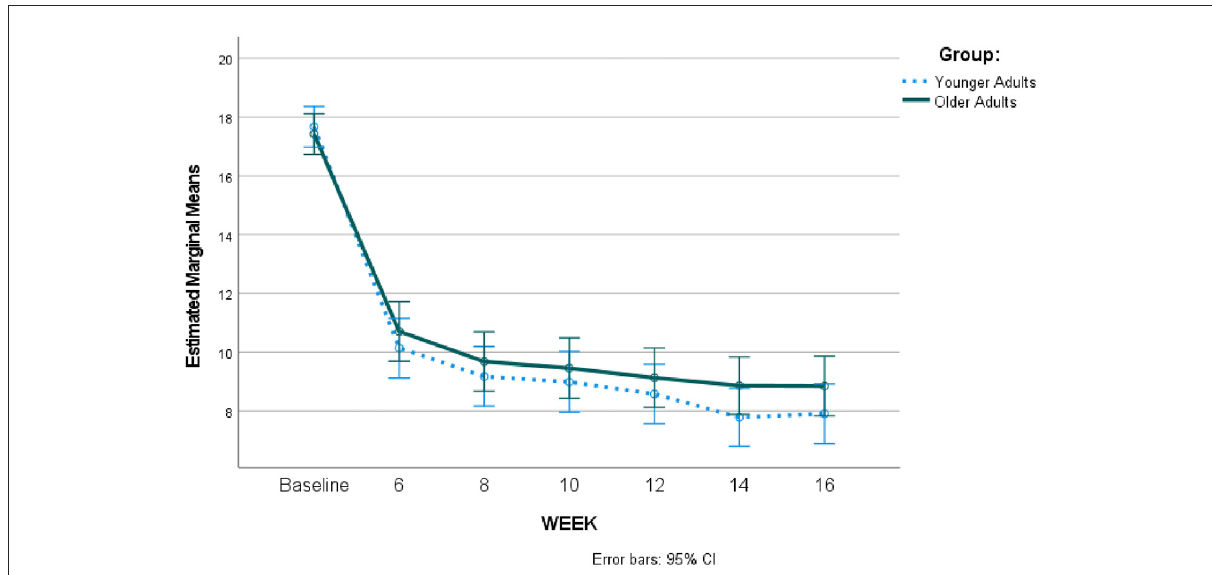
FIGURE1 Repeated measures results comparing young vs adults depression severity over time during telepsychiatry